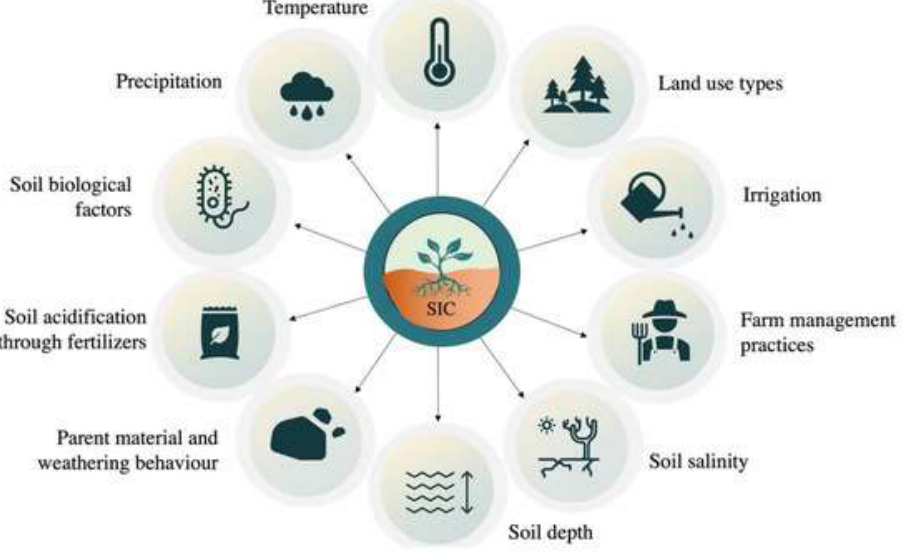
Figure 3. Natural and anthropogenic factors influencing the formation of soil inorganic carbon in dryland soils (Naorem, A [18]).